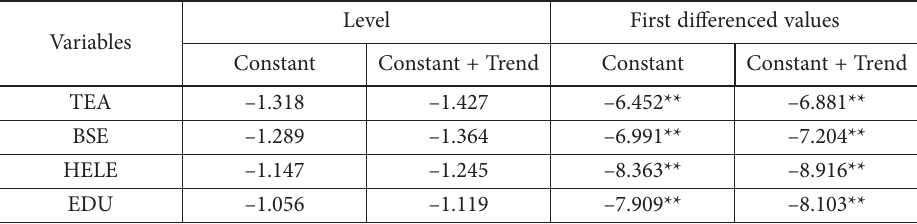
Table 5. CIPS Unit Root Tests (H 0 : The series has unit root)